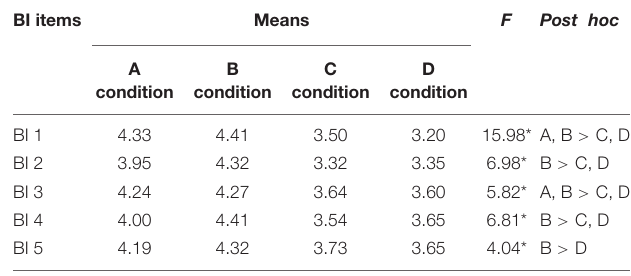
TABLE 5 | Heat maps.